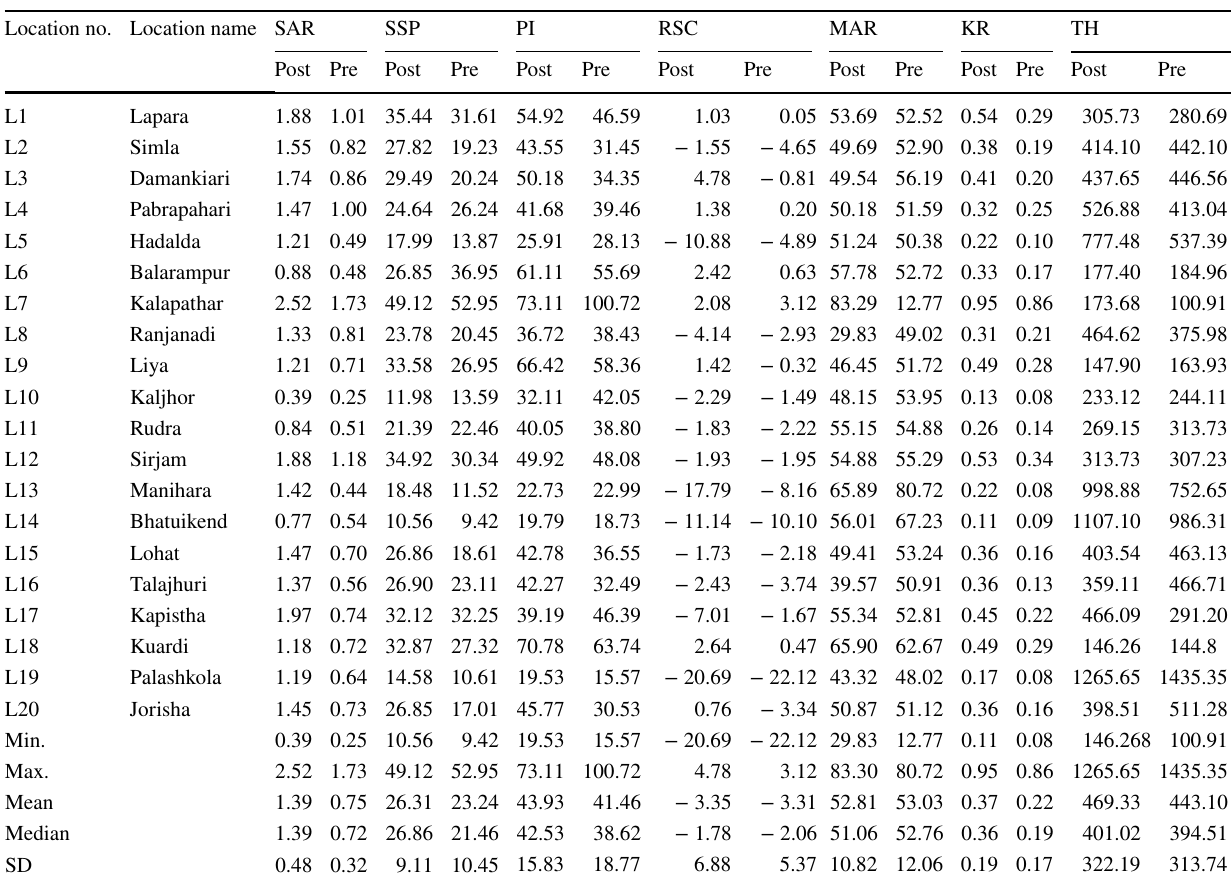
Table 4 Values of water quality indices Location no. Location name